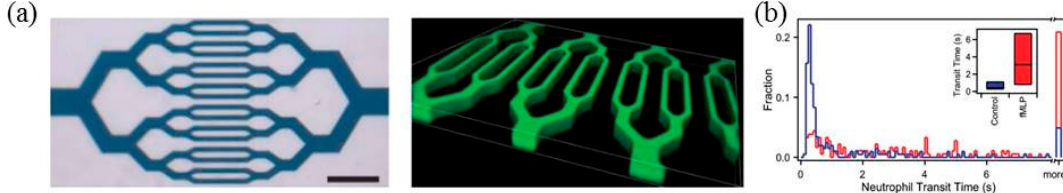
Figure 4. ( a ) Schematic of the constriction channel network for the mechanical property characterization of WBCs where the device trifurcates into a network of bifurcating channels including 64 parallel constriction channels; ( b ) The transit time of the neutrophil populations with or without fMLP exposure. Note that fMLP is an inflammatory mediator involved in sepsis; ( c ) Four samples of leukemia patients were flushed through the constriction channels to quantify the differences of transit time: two leukostasis-asymptomatic ALL samples (ALL1 and ALL2), one leukostasis-asymptomatic AML sample (AML1), and one leukostasis-symptomatic AML sample (AML2). These results show that the cellular transit time distribution from a leukostasis-symptomatic patient is distinct from cells of leukostasis-asymptomatic patients. Reproduced with permission from [24].